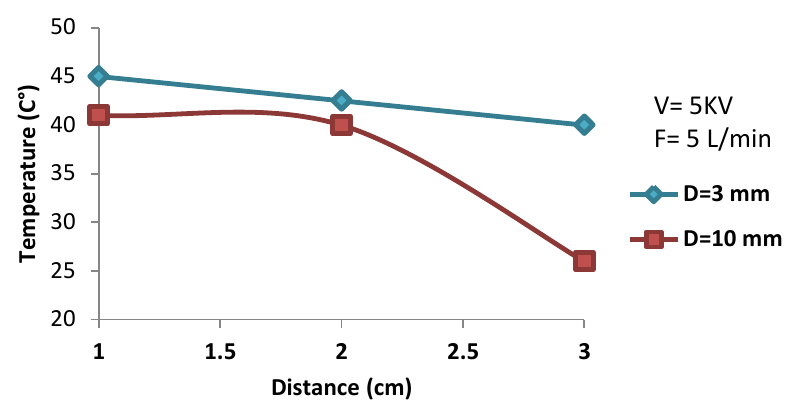
Fig.5: The relationship between the temperature of the gas and distance.